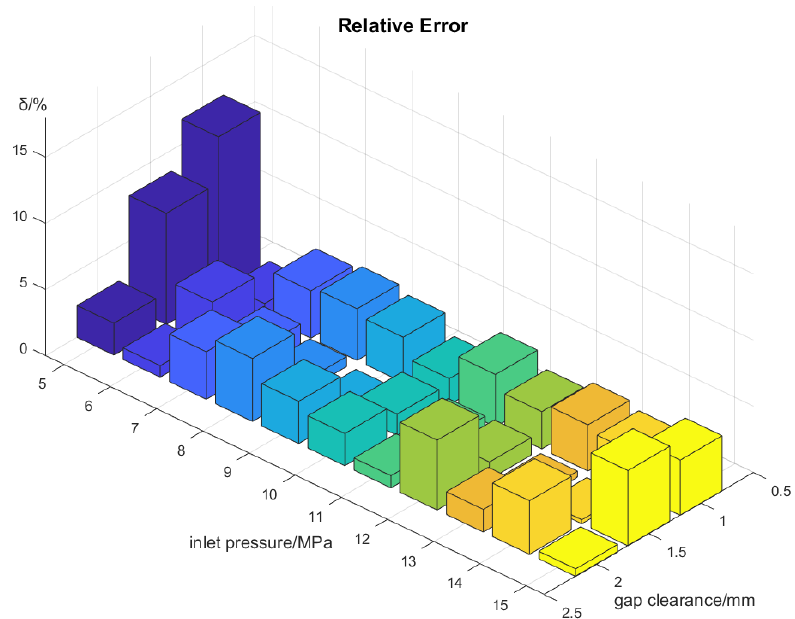
Figure 10. Relative error between simulations and experimental tests with different inlet pressure and gap clearance of the original suction cup.